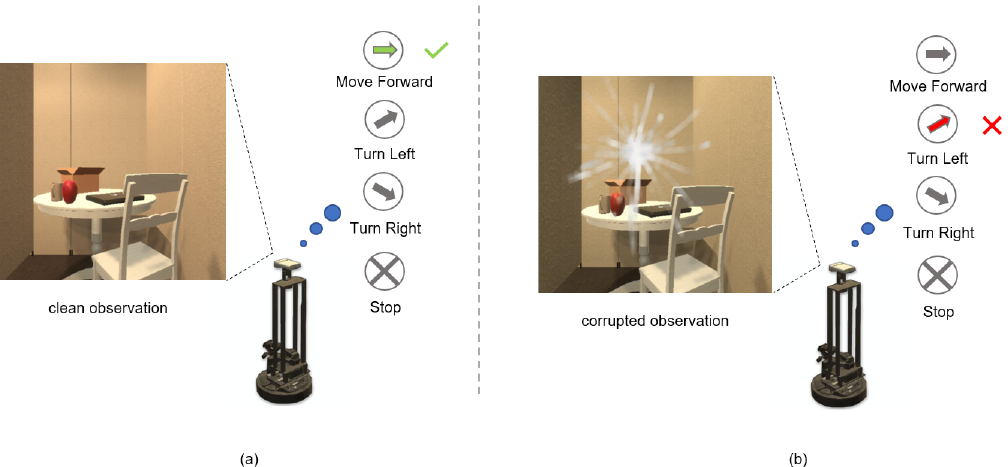
Figure 1. Illustration of navigation under clean/corrupted observation. ( a ) Optimal action decision under clean observation. ( b ) Non-optimal action decision under corrupted